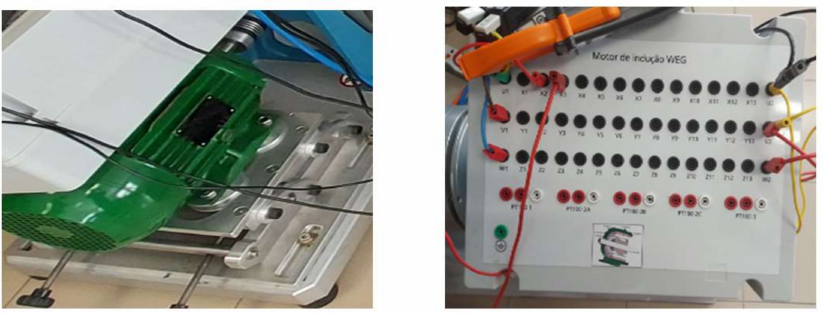
Figure 10. Induction motor used for the ITSCF tests.